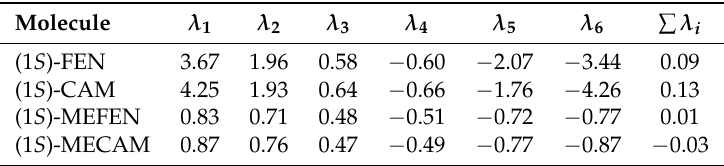
Table 4. VCD Intensity Carrying Modes (ICM)s of the four chiral compounds for which the corresponding simulated and experimental spectra are reported in Figures 6 and 7. The APTs and AATs required for the evaluation of ICMs have been computed at the B3LYP/aug-cc-pVTZ level of theory. All numerical data are given in the atomic units of the M VCD matrix. λ